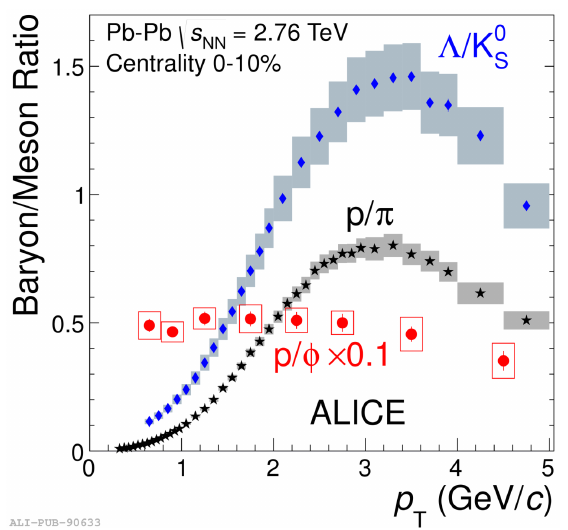
Figure 3. Λ /K 0 s vs. p T compared to the p/ π ratio. The φ /p ratio is reported as well. Figure taken from [10].